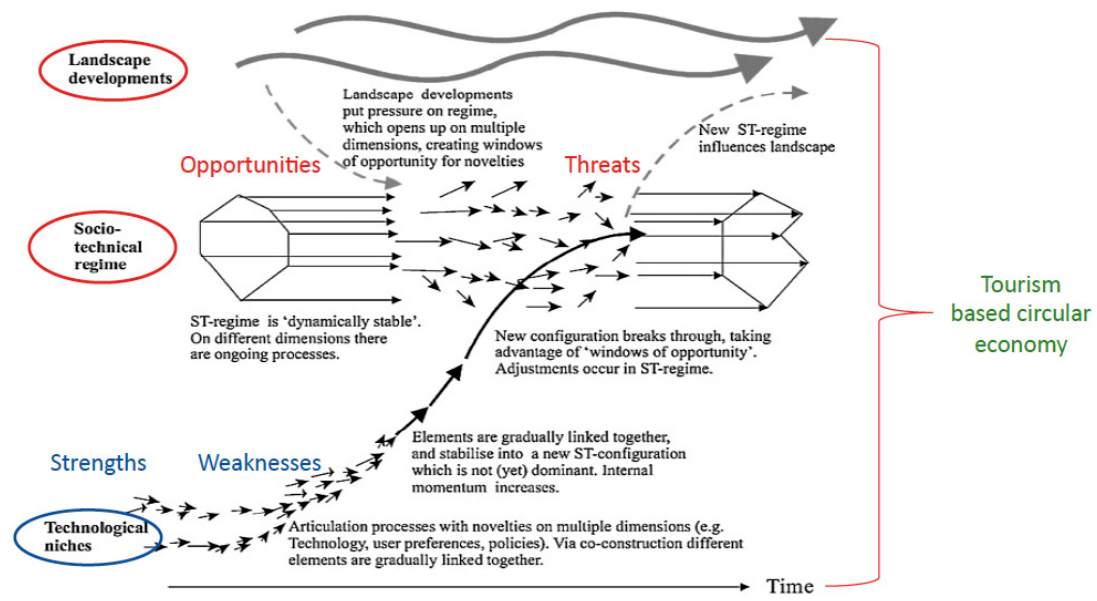
Figure 1. Strengths, Weaknesses, Opportunities and Threats - Multi-Level Perspective (SWOT-MLP) for a transition towards a tourism-based circular economy. Source: adapted from Falcone et al. (2019) and Geels (2011).